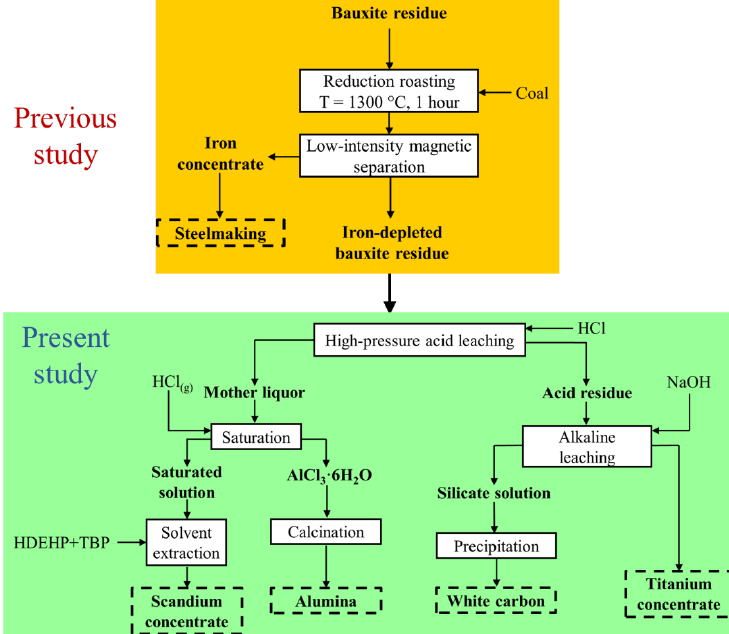
Figure 1. A conceptual flowsheet of bauxite residue treatment in the present and previous studies.